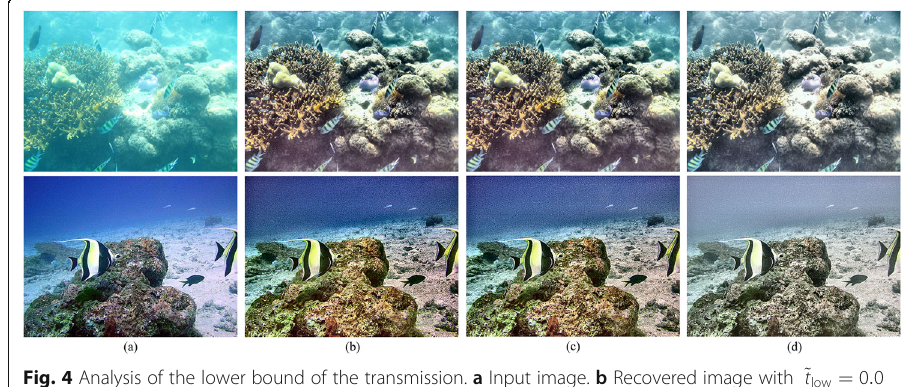
Fig. 4 Analysis of the lower bound of the transmission. a Input image. b Recovered image with ~ t low ¼ 0 : 0 5. c Recovered image with ~ t low ¼ 0 : 1. d Recovered image with ~ t low ¼ 1 :